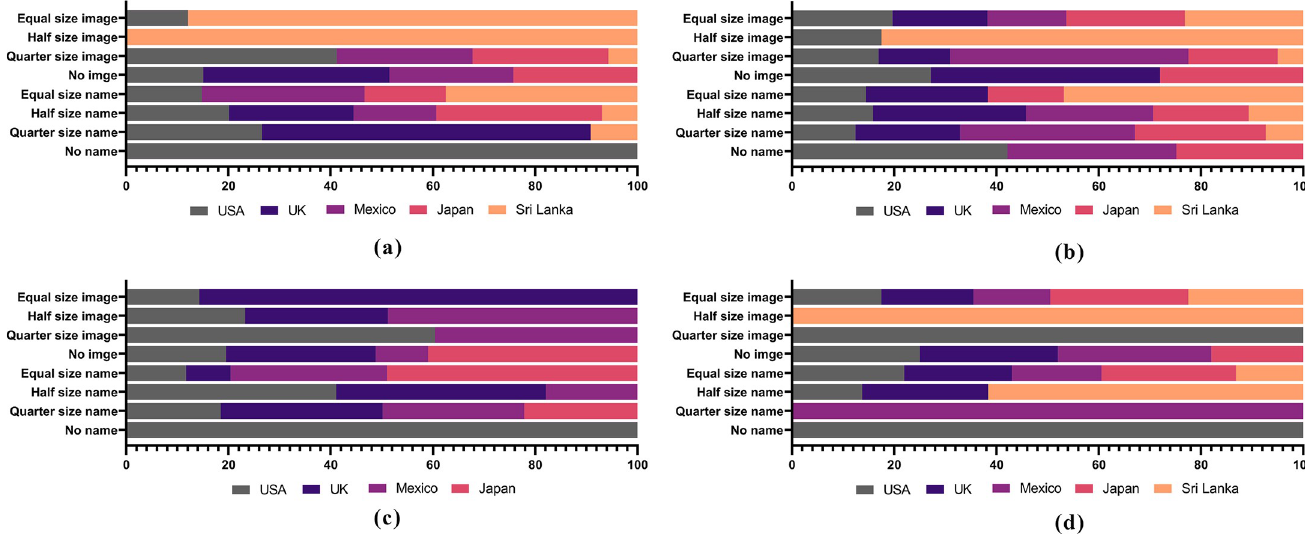
Fig 7. Assessment of positioning strategy through label objects. Assessment of positioning strategy through label objects: an image of cinnamon and word, cinnamon in cinnamon-based breakfast cereals (a); cinnamon tea (b); cinnamon based bakery and confectionery (c); and nutraceuticals (d).